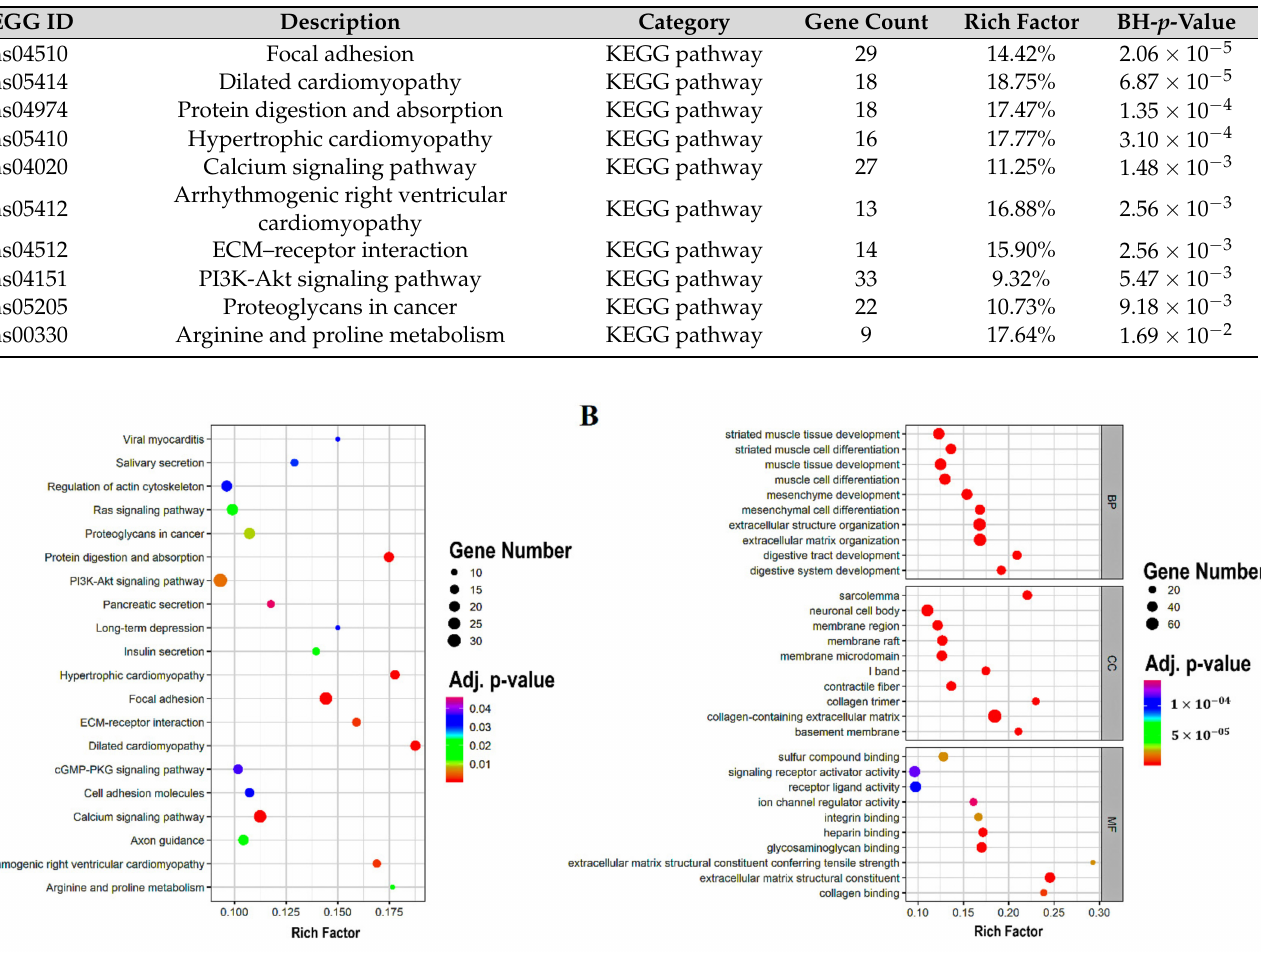
Figure 3. The scatter plots of the KEGG pathway and the GO enrichment. ( A ) The top 20 KEGG pathways are shown in a scatter plot. ( B ) The scatter plot of the top 10 separate GO terms. The Rich factor is the proportion of DEGs numbers among all gene numbers (in the database), indicated in the pathway term that is linked to it. KEGG, Kyoto Encyclopedia of Genes and Genomes; GO, gene ontology; DEGs, differentially expressed genes; BP, biological process; MF, molecular function; and CC, cellular